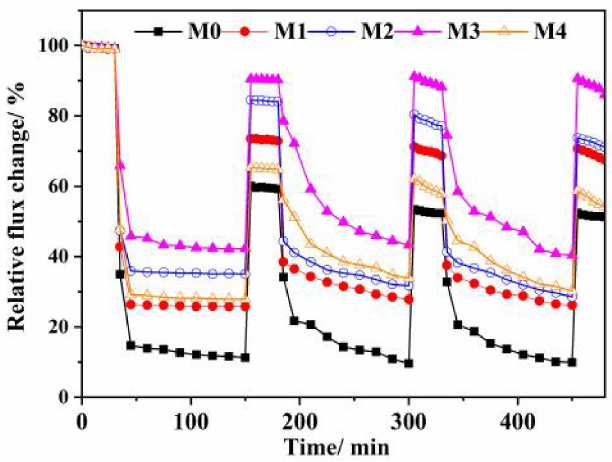
Figure 8. Relative water flux changes with filtration time for the various prepared membranes during the filtration of oil emulsion (c f = 100 mg/L) for three consecutive